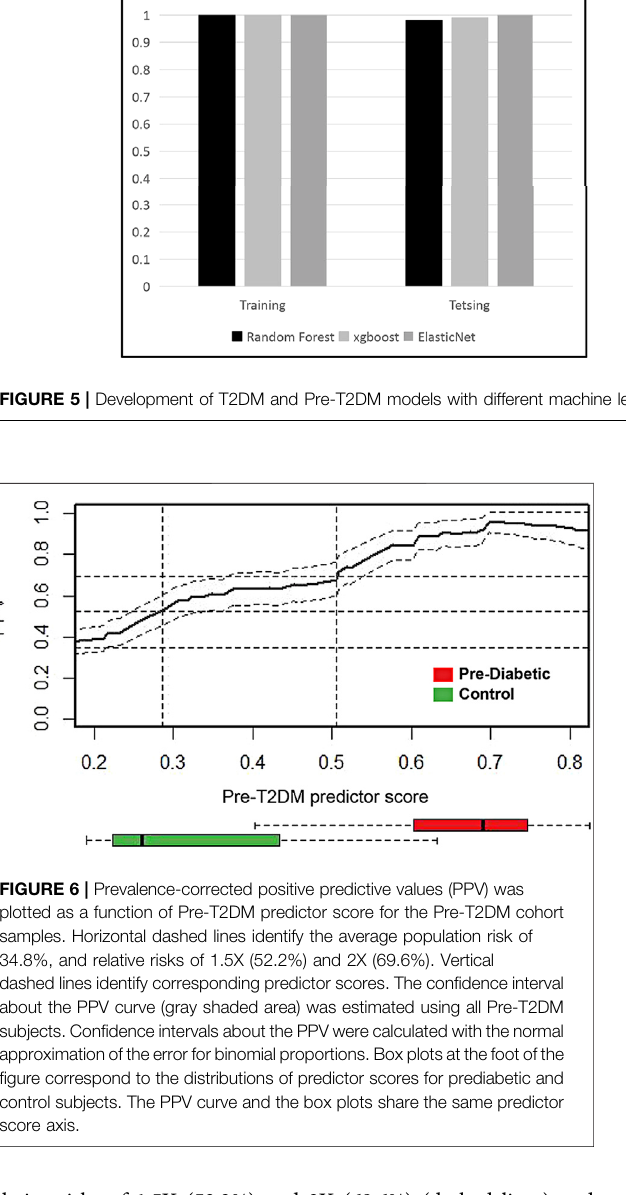
relative risks of 1.5X (52.2%) and 2X (69.6%) (dashed lines) and higher. The distribution of Pre-T2DM predictor score values for subjects color-coded (green, controls; red, Pre-T2DM) are shown in box plots in Figure 6 . Using the risk curve in Figure 6 , Pre-T2DM subjects were identi fi ed as high or low risk according to a predictor score cutoff corresponding to 2X relative risk (PPV of 69.6%, predictor score = 0.505).